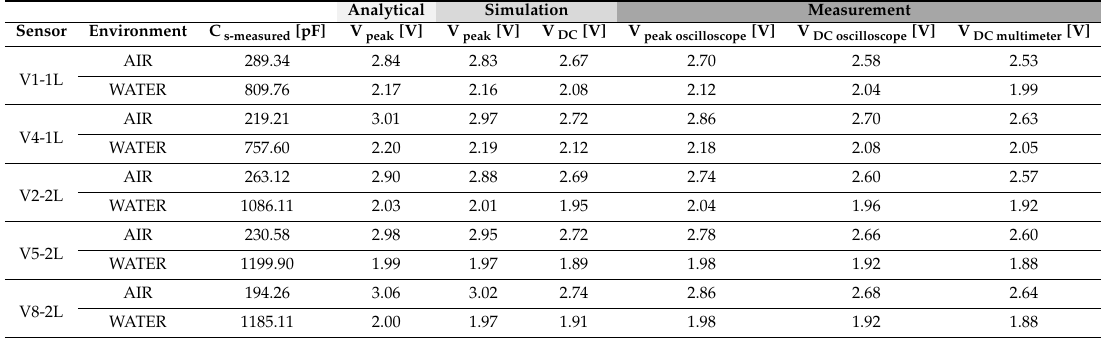
Table 5. Analytical, simulation and measurement results for the capacitance measurement circuit. The peak AC voltage at the capacitor sensor and the DC value outputted from the peak detector circuit are investigated.